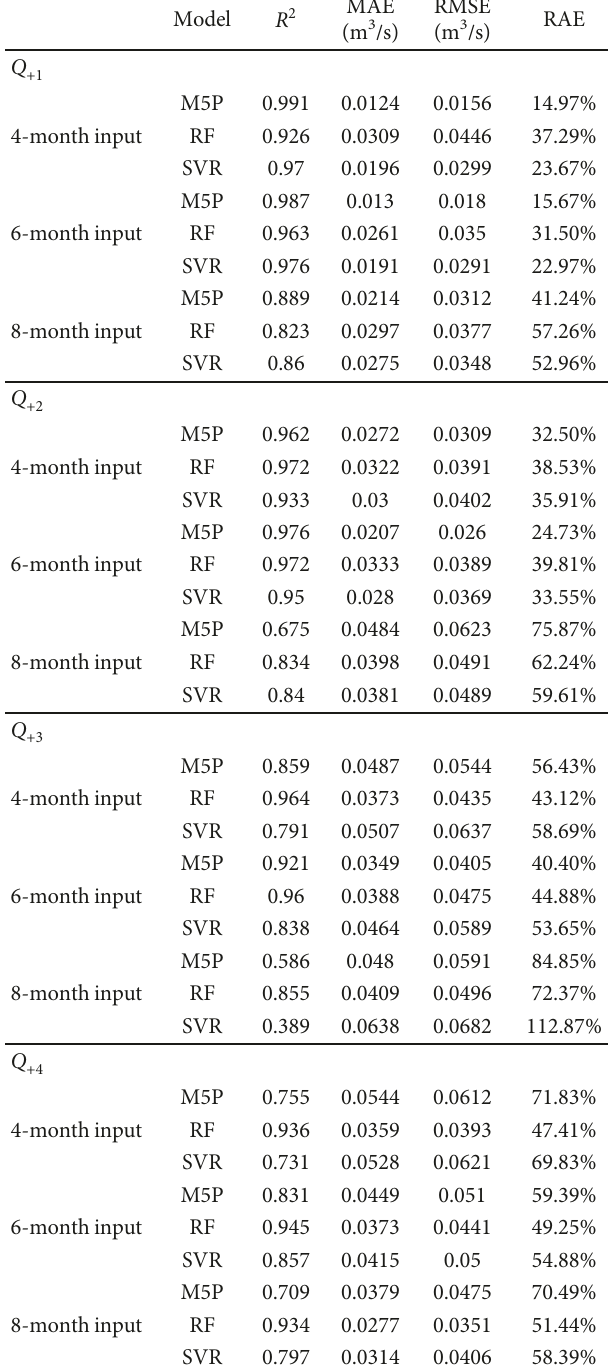
Table 1: Comparative analysis of M5P, RF, and SVR by means of R 2 , MAE, RMSE, and